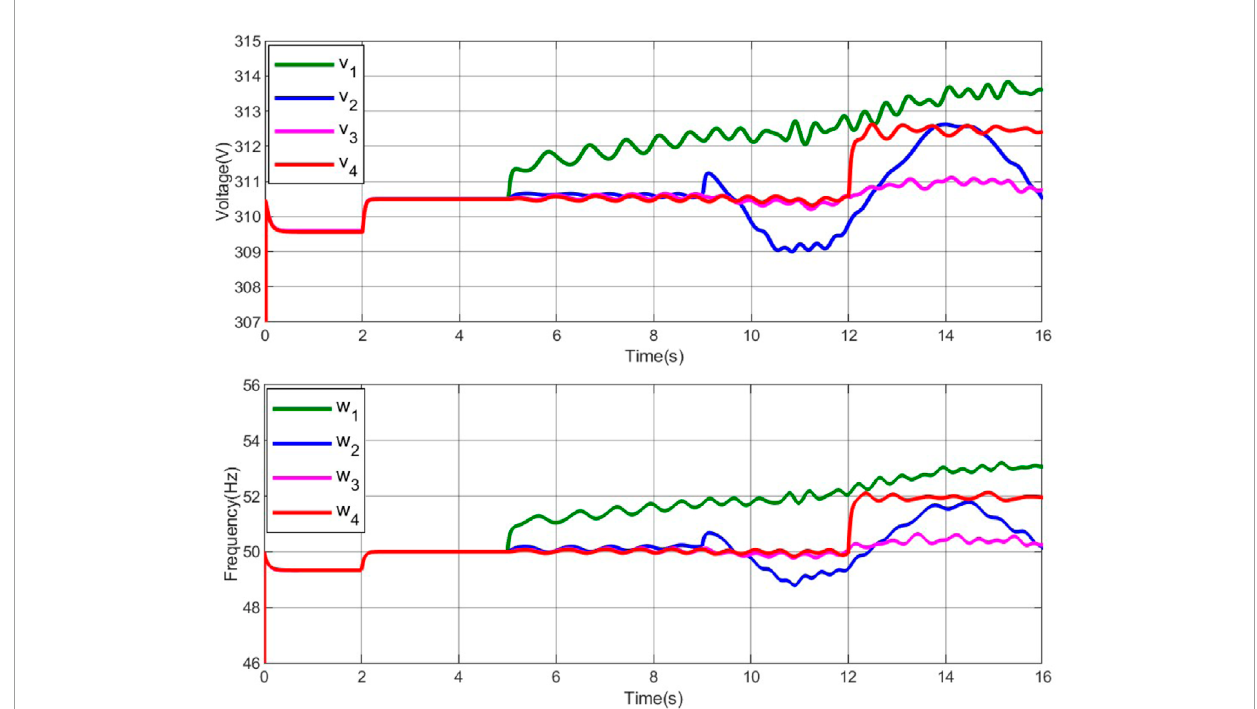
FIGURE 2 Trajectories of voltage and frequency with the distributed secondary controller (8)–(9) under faults.